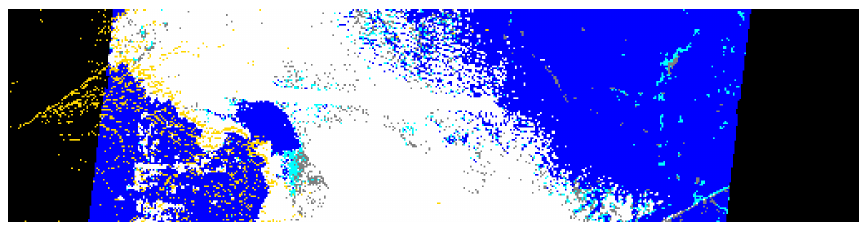
Figure 9. Map of the final updated (Stage D) MISR RCCM for Path 168, Orbit 68283, Block 110 and camera CA. Missing pixels have been replaced by estimates of the cloud or clear status of the observed areas, based on the cloudiness level of neighboring cameras and neighboring pixels within small subwindows of the target camera, as described in the text. The enlargement and linear dimensions of the mapped area are identical to those indicated in Fig. 3. Color coding: red, no retrieval or fill value; white, cloud with high confidence; gray, cloud with low confidence; aqua, clear with low confidence; blue, clear with high confidence; gold, pixels obscured by topography; and black, pixels at the edges of the instrument swath.